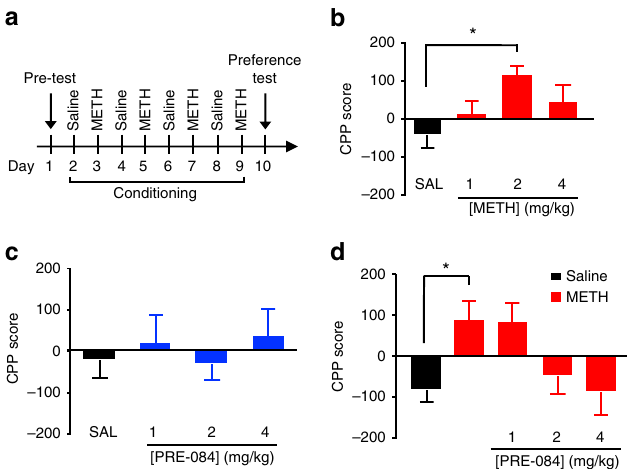
Fig. 6 σ 1 R activation decreases METH-induced conditioned place preference. a Experimental paradigm for conditioned place preference (CPP) is shown. b Dose-response experiment using 1, 2, and 4 mg/kg METH ( n = 11, 12, 11 C57BL/6 mice, respectively) produced reproducible CPP for METH. 2 mg/kg METH showed the largest CPP on the post- conditioning test compared to saline (SAL)-treated mice ( F (3,41) = 2.954, P = 0.0436; with Tukey ’ s test for multiple comparisons, * P < 0.05). Therefore, 2 mg/kg METH was used for all further CPP studies. c Neither 1, 2, nor 4 mg/kg PRE-084 ( n = 4, 8, and 8 mice, respectively) showed CPP or conditioned place aversion compared to saline treatment ( n = 8 mice). compared to saline-treated animals ( n = 12 mice). Treatment with 1, 2,